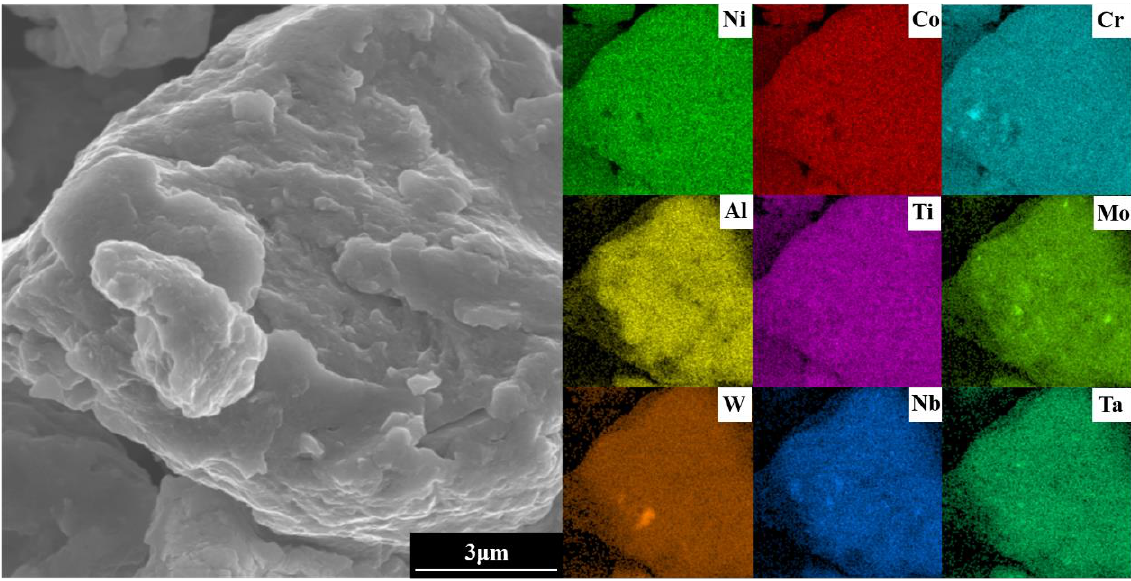
Figure 10. EDS images of the agglomerates in the alloy powder.